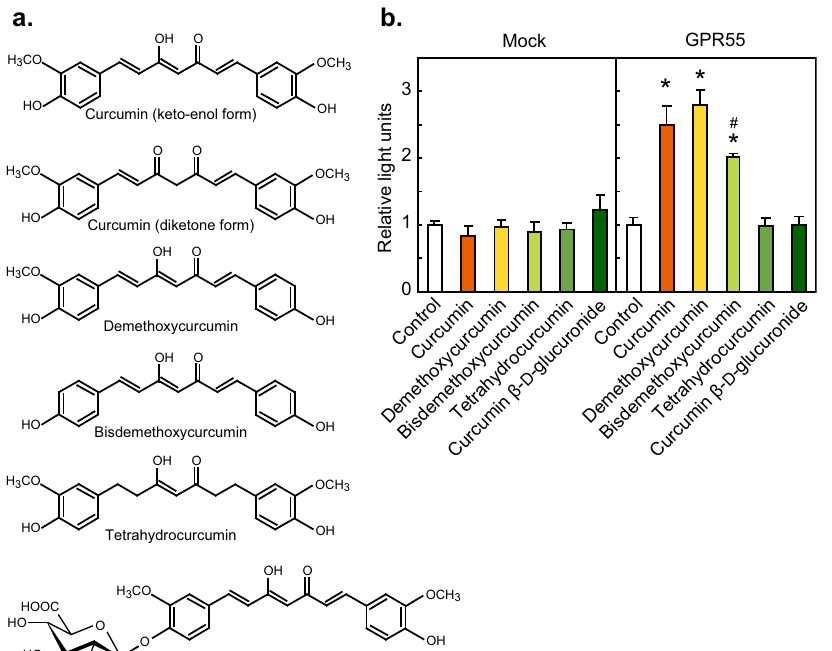
Fig. 2 Effects of curcuminoids and tetrahydrocurcumin on the activation of GPR55. a Chemical structures of curcuminoids, the major curcumin metabolite tetrahydrocurcumin, and the major conjugate curcumin β - D -glucuronide. b HEK293-FT cells transfected with the GPR55 expression vector, p3xSRE-TATA-Luc2P, and pGL4.74[ hRluc /TK] were stimulated with each compound at 10 µM and reporter assay was performed. Data were expressed as the mean ± s.d. ( n = 4). Statistical analysis was performed on each of the wells transfected with the mock vector or the GPR55 expression vector. * p < 0.05 vs control; # p < 0.05 vs . both control and compound 1